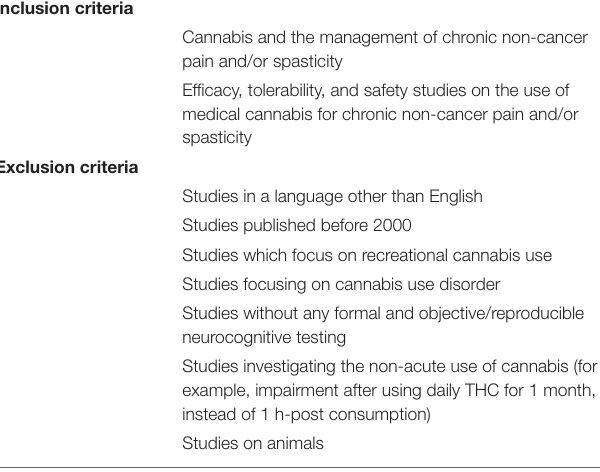
TABLE 2 | Inclusion and exclusion criteria (for medical cannabis patients using cannabis for chronic non-cancer pain or